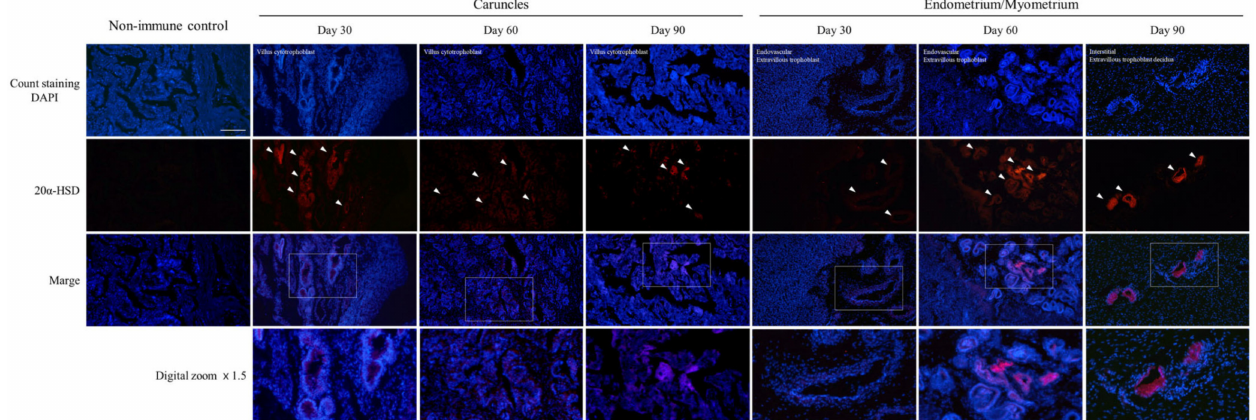
Figure 3. Immunofluorescence detection of 20 α -HSD protein expression patterns in tissues during early pregnancy. The non-immune control was not treated with the first antibody; only the secondary antibody was treated to compare whether there was abnormal expression. White arrows indicate areas with distinct expressions. Red fluorescence indicates gene expression. Scale bar = 100 µ